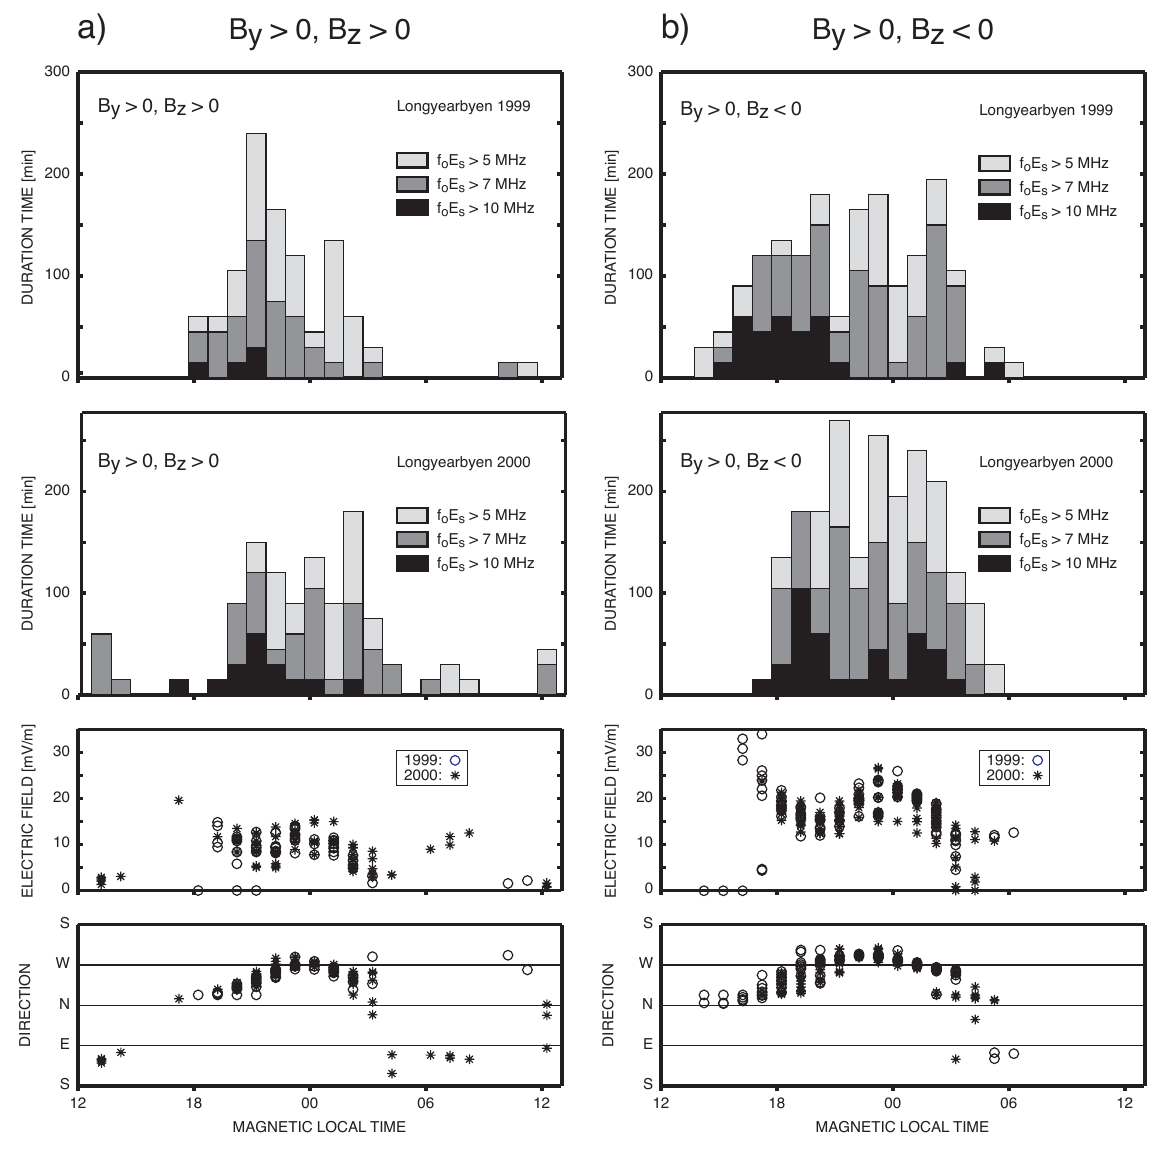
Fig. 6. (a, b) Diurnal distributions of Es occurrence in 1999 and 2000 at Longyearbyen, when (a) both B y and B z are positive (left) and ( b) B y is positive and B z is negative (right). The amplitude and direction of the ionospheric electric field, calculated from simultaneous observations of the IMF using the statistical APL convection model are also shown. Cases with zero electric field come from incidents when the IMF is stronger than the highest value accepted by the APL